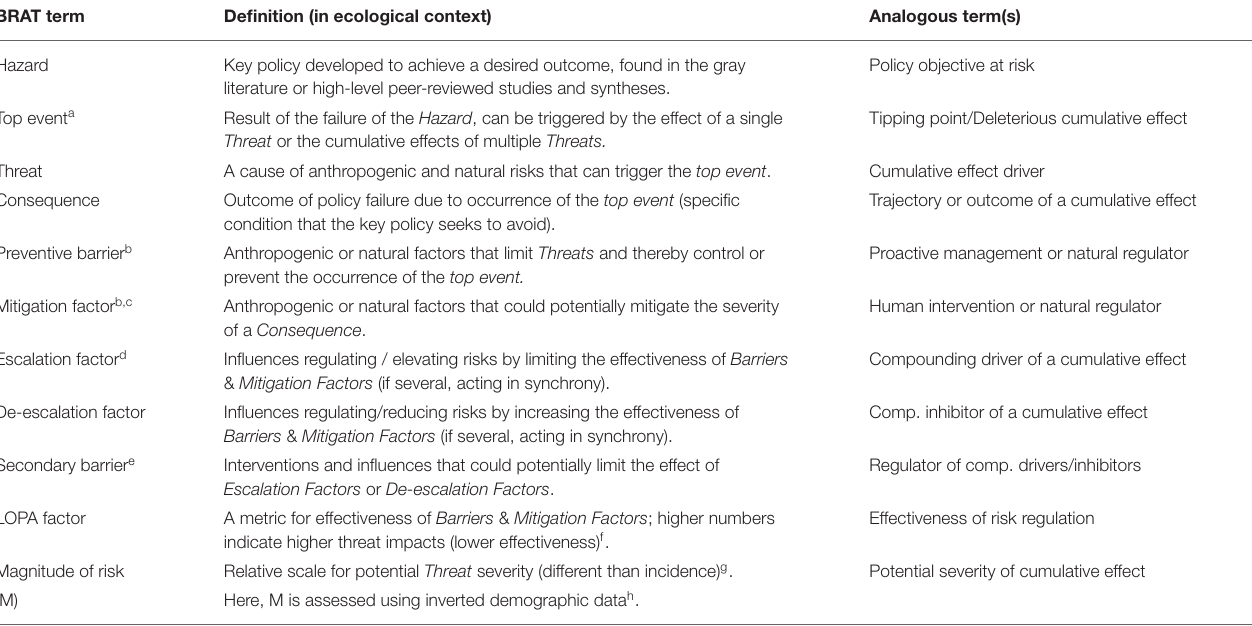
TABLE 1 | Terminology used in the Bowtie Risk Assessment Tool (BRAT) with definitions and analogous terms.